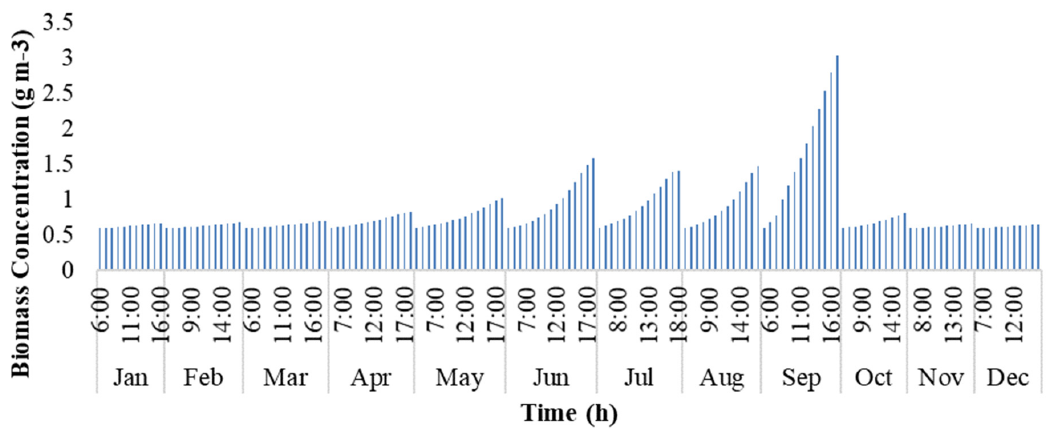
Figure 16. Change in biomass concentration with time inside the Raceway Pond.